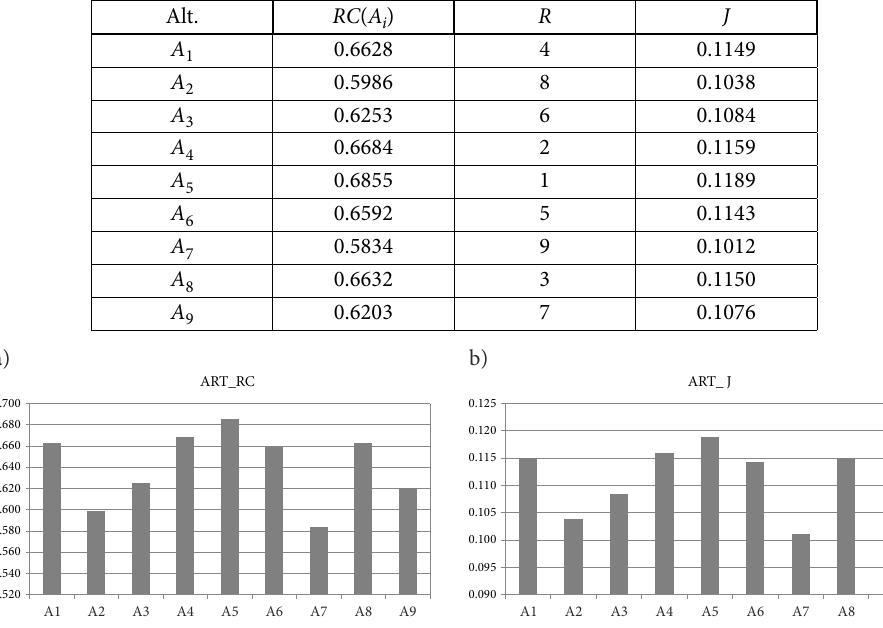
Table 7. Rankings of gerontechnologies after using the aggregation operator (18) with objective criteria weights Alt.